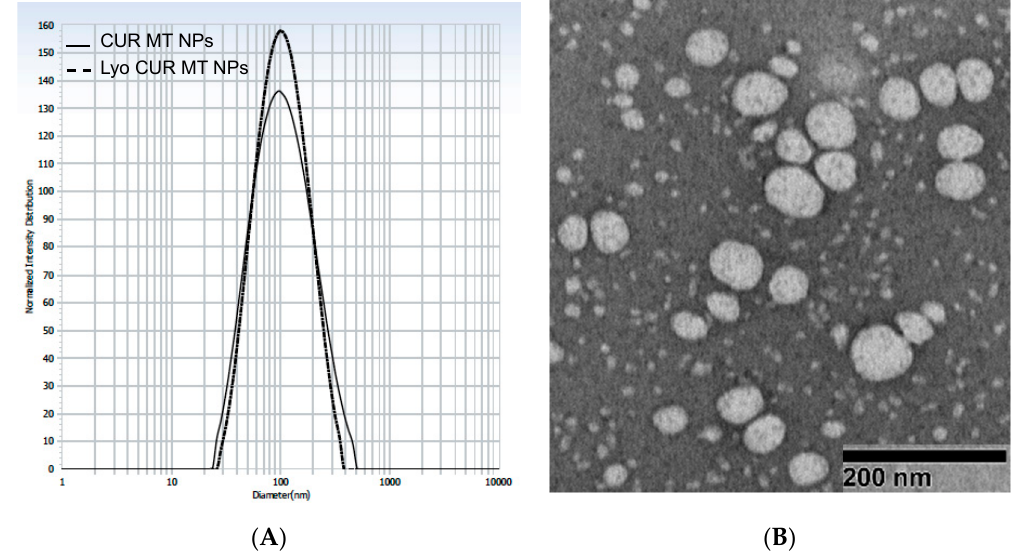
Figure 1. Particle size and size distribution of CUR MT NPs and Lyo CUR MT NPs. Particle size was measured by dynamic light scattering (CUR MT NPs and Lyo CUR MT NPs) ( A ) and TEM (CUR MT NPs) ( B ). Lyo CUR MT NPs were obtained by reconstitution of lyophilized CUR MT NPs.